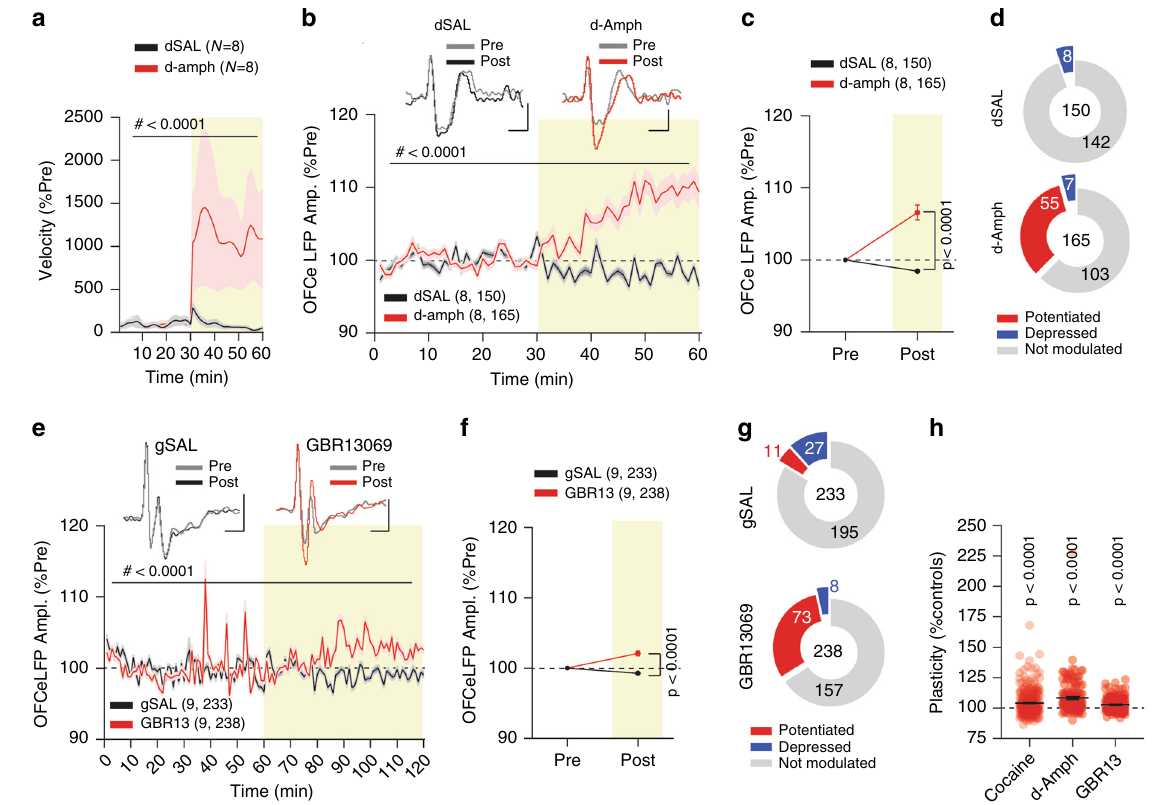
Fig. 4 Dopamine-dependent OFC-DMS input strengthening. a Time-course of norm. velocity for saline (dSAL) and d-amphetamine (d-amph) (RM two- way ANOVA, time main effect: F (1.064,14.90) = 2.685, p = 0.1209; drug main effect: F (1,14) = 3.039, p = 0.1032; time Χ drug interaction: F (59,826) = 2.753, p < 0.0001). b Time-course of normalized OFCe LFP responses (two-way ANOVA; time main effect: F (59,18780) = 10.90, p < 0.0001; drug main effect: F = 744.80, p < 0.0001; time Χ drug interaction: F = 18.63, p < 0.0001). Scale bar: 20 ms, 2 μ V. c Binned OFCe LFP amplitude (two-way (1,18780) (59,18780) ANOVA; time main effect: F (1,626) = 21.20, p < 0.0001; drug main effect: F (1,626) = 54.76, p < 0.0001; time Χ drug interaction: F (1,626) = 54.76, p <